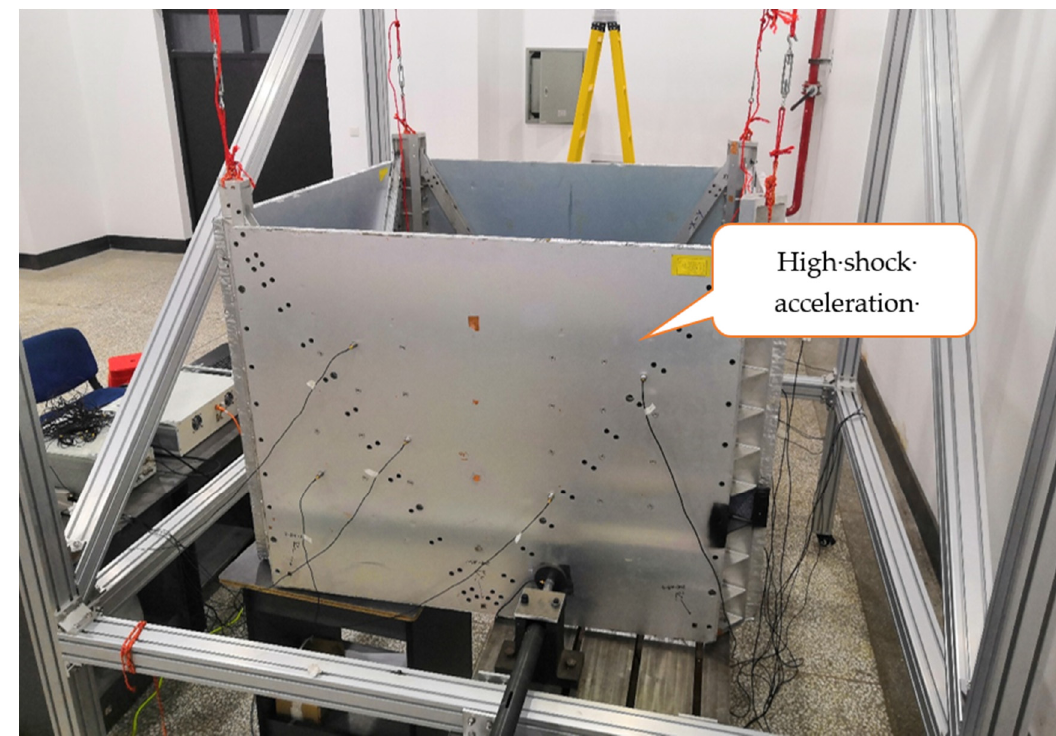
Figure 3. Shock experiment of the typical spacecraft structure.